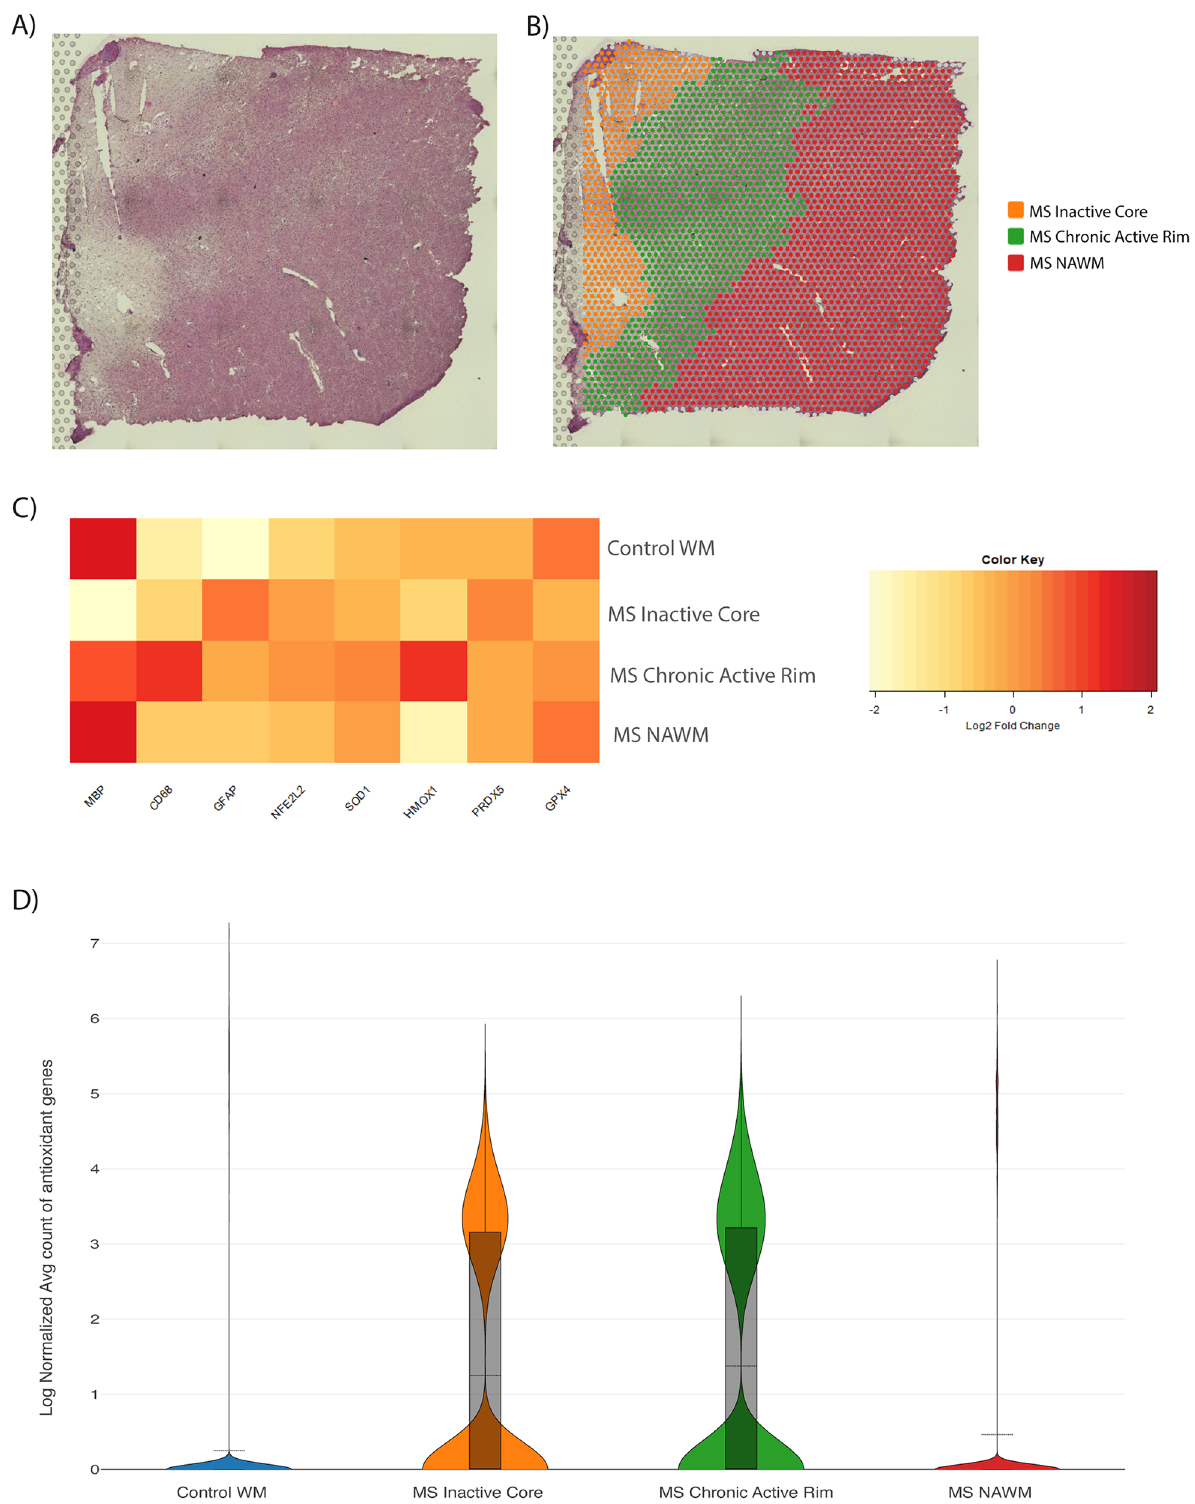
Figure 5. Spatial transcriptomic analysis of antioxidant protein expression in chronic active MS brain lesions. ( A ) Representative microscopy image of post-mortem MS brain tissue labeled with hematoxylin and eosin. This is a white matter region of the frontal lobe. ( B ) Spatial demarcation of the MS tissue into anatomical regions (NAWM, inactive core, and active edge) based on their expression of MBP and cellularity. ( C ) Heatmap showing the expression of genes across control WM and the segmented regions of MS tissue. ( D ) Violin plot showing the combined sum of expression of SOD1 , HMOX-1 , PRDX5 , and GPX4 in the different anatomical regions of the MS tissue. Data representative from 2 healthy control and 2 MS